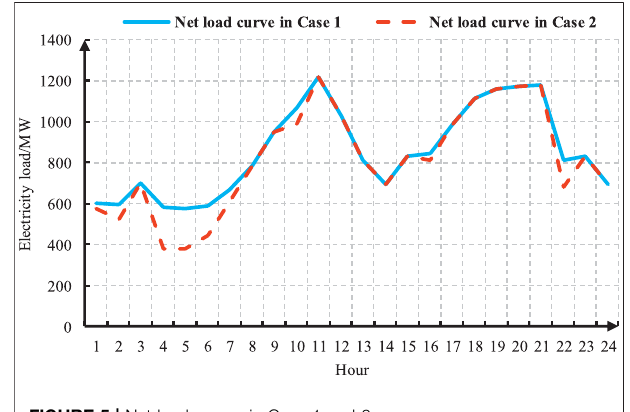
FIGURE 5 | Net load curves in Case 1 and 2.